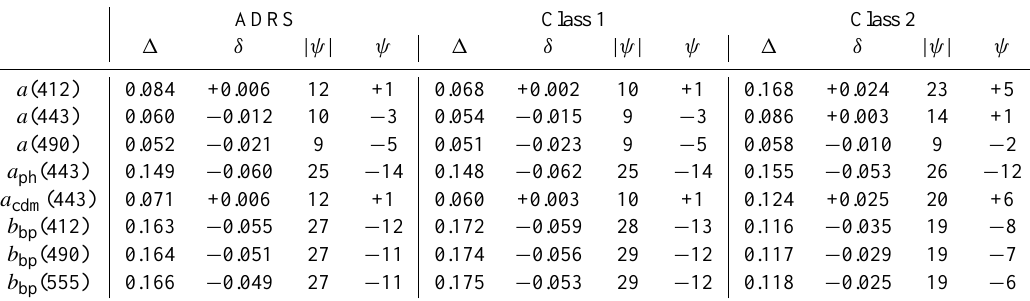
Table 1. Average statistics calculated using the grid points with more than 100 matching pairs for the entire basin (ADRS), as well as for the regions most often classified as optical Class 1 or Class 2 (see text for definition). | ψ | and ψ are in expressed in